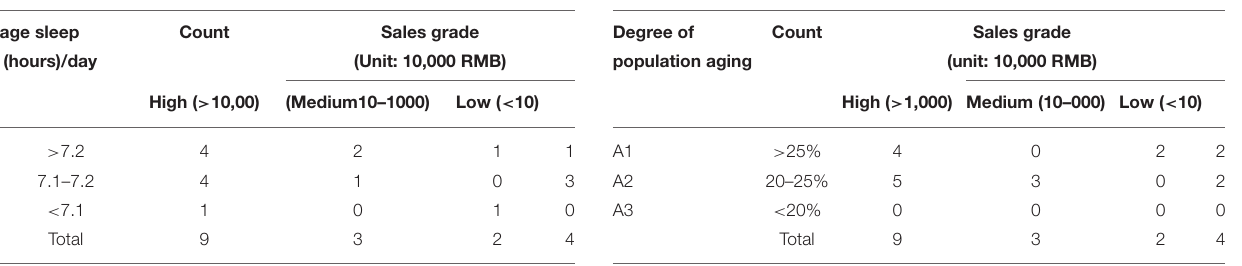
TABLE 8 | Data analysis of degree of population aging and sales of smart beds.